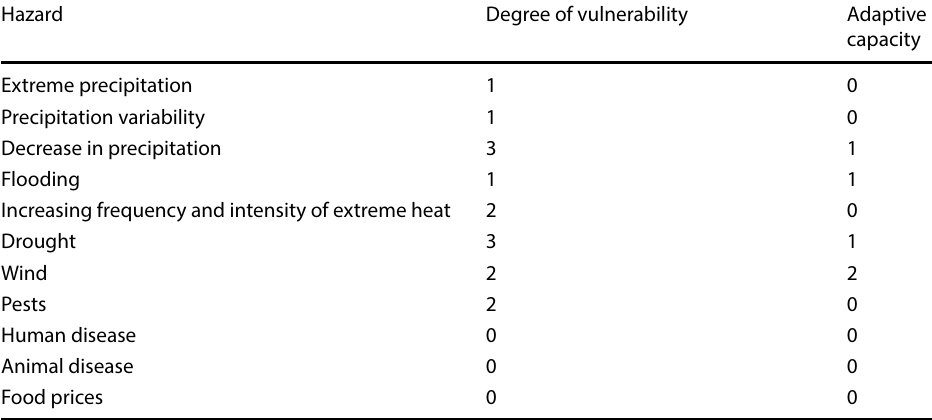
Table 5 Farmers perception with regards to the degree of vulnerability to food security related hazards